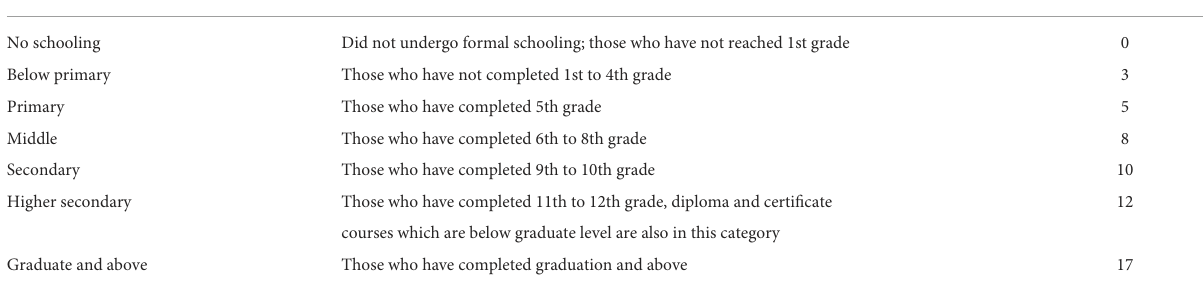
TABLE 1 Educational attainment